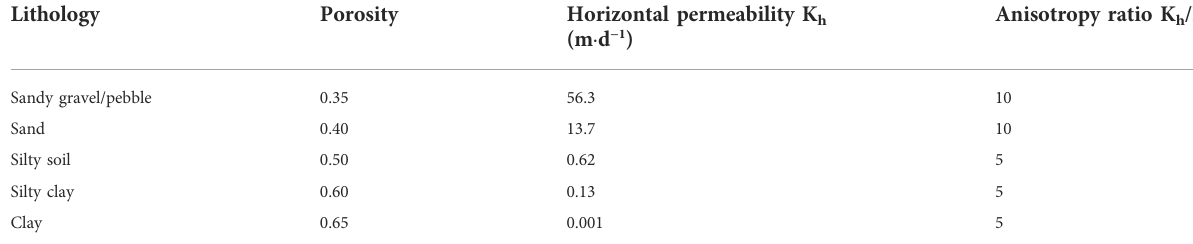
TABLE 2 Hydrological parameters of the calibrated model.